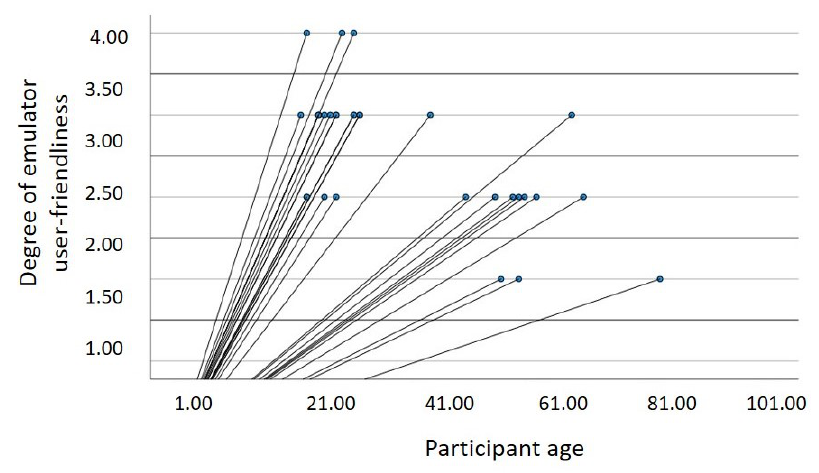
Figure 15. Relationship between age and ease of using the emulator. Hypothesis 5. The performance of men and women using the emulator is